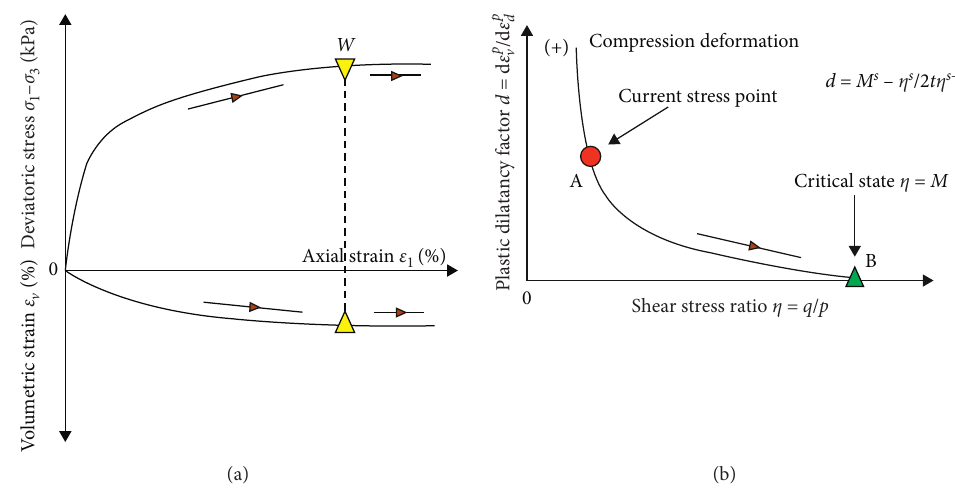
Figure 6: Schematic of the dilatancy of the gravelly sand. (a) Triaxial shear test results. (b) Schematic of